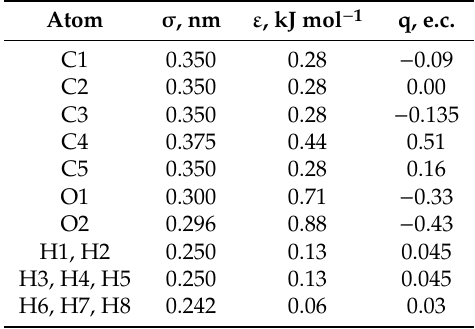
Table 1. Energy parameters and partial atomic charges for used potential model of poly (methyl methacrylate) (PMMA).